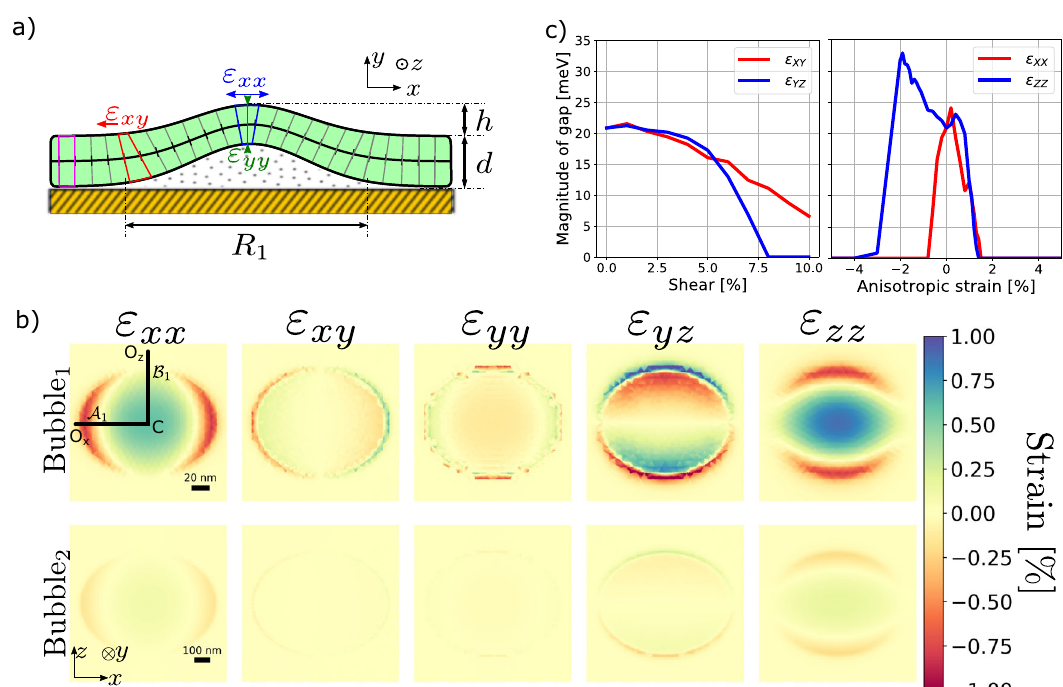
Fig. 3 Numerical results. a A simpli fi ed view of the strain patterns in a bubble. The yellow, black dashed region indicates the gold substrate. The middle black solid line depicts the neutral plane, which shares the same geometrical parameters as the unstrained crystal. The different trapezoid quadrilaterals indicate the different strain patterns. We have also indicated the geometric parameters. b Strain pattern on the top surface of the bubbles obtained by fi nite element calculations (COMSOL). This is the surface measured by STM. The top row corresponds to Bubble 1 , the bottom row to Bubble 2 . The different panels show different strain tensor components. Negative values correspond to compression. c The in fl uence of different strain components on the electronic properties. The magnitude of the gap as the function of the strain components, calculated by